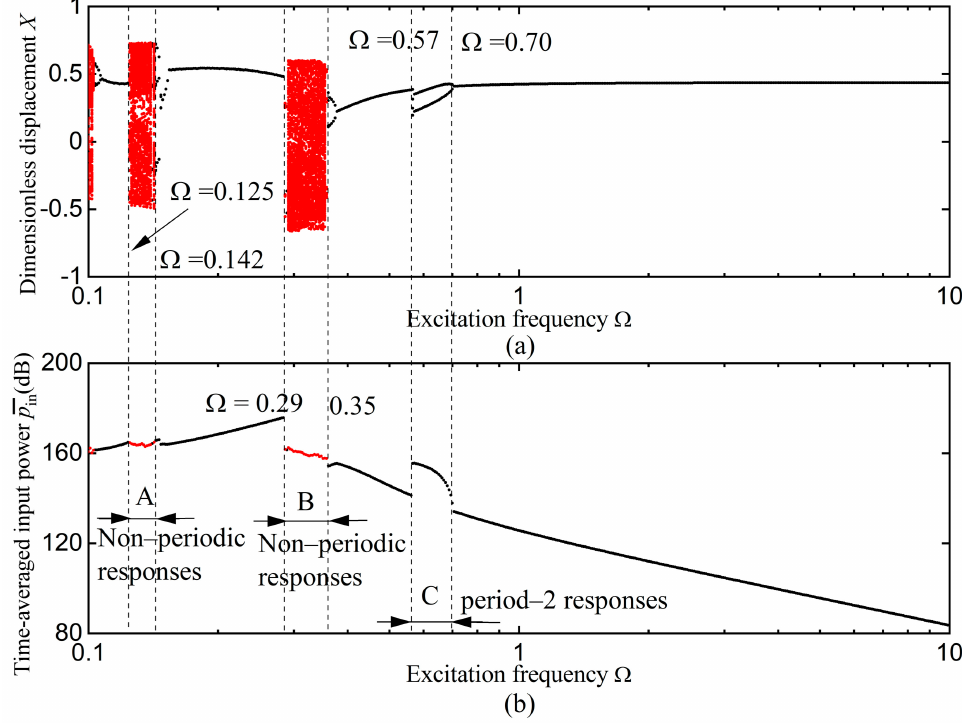
Figure 14. Bifurcation diagrams of ( a ) displacement response and ( b ) time–averaged input power with high to low excitation